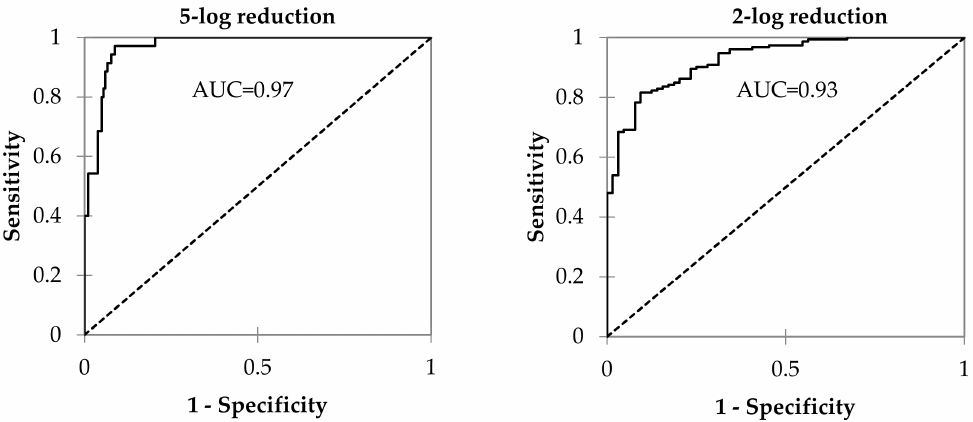
Figure 6. Receiver operating characteristic curves (ROC) of logistic regression models to predict the Salmonella population’s 5- and 2-log